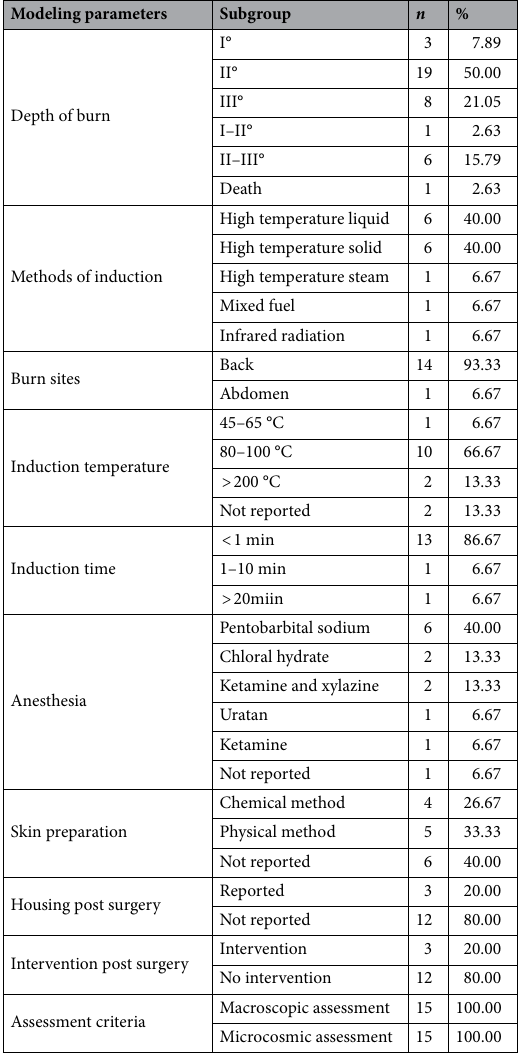
Table 1. The summary of the findings for the various parameters of the models.